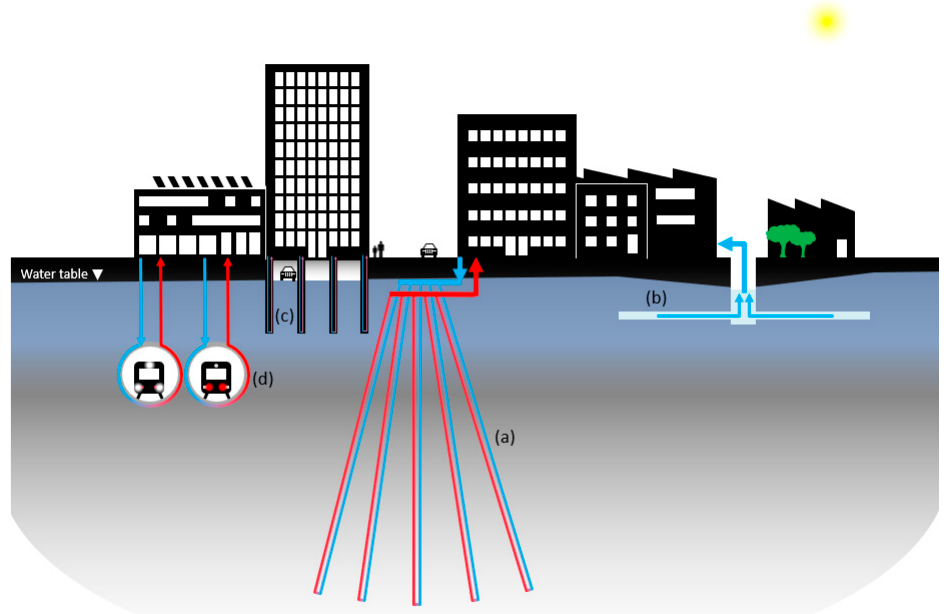
Figure 2. SGE specific solutions in urban environments: tilted BHEs with reduced surface footprint 231 ( a ); radial groundwater horizontal wells for GWHEs ( b ); TAFs ( c ); and thermally-activated underground metro tunnels ( d ).